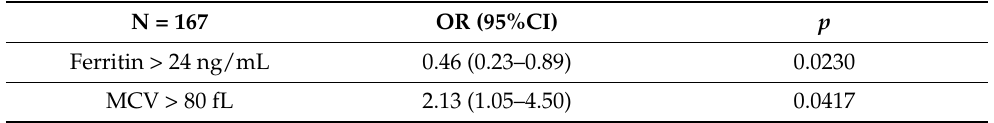
Table 3. Results of multiple logistic regression for hematologic variables and the presence of ASD, reciprocally adjusted and adjusted for age and